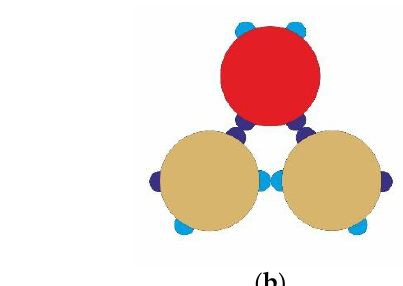
Figure 2. The three possible building blocks for the Rh-family structures: ( a ) Rh-phase formed from PPs type I only; ( b ) Rh-phase formed from PPs type II only ( c ) Mixed Rh-phase formed from PPs type I and type II.